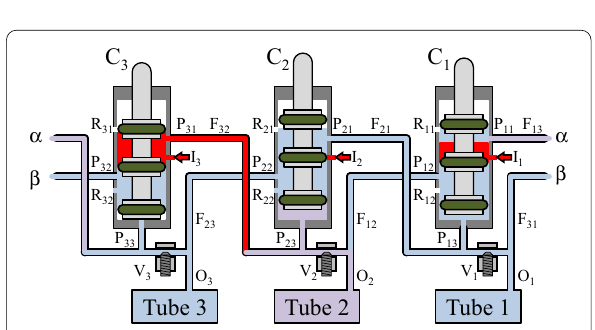
Fig. 13 Unstable states of the